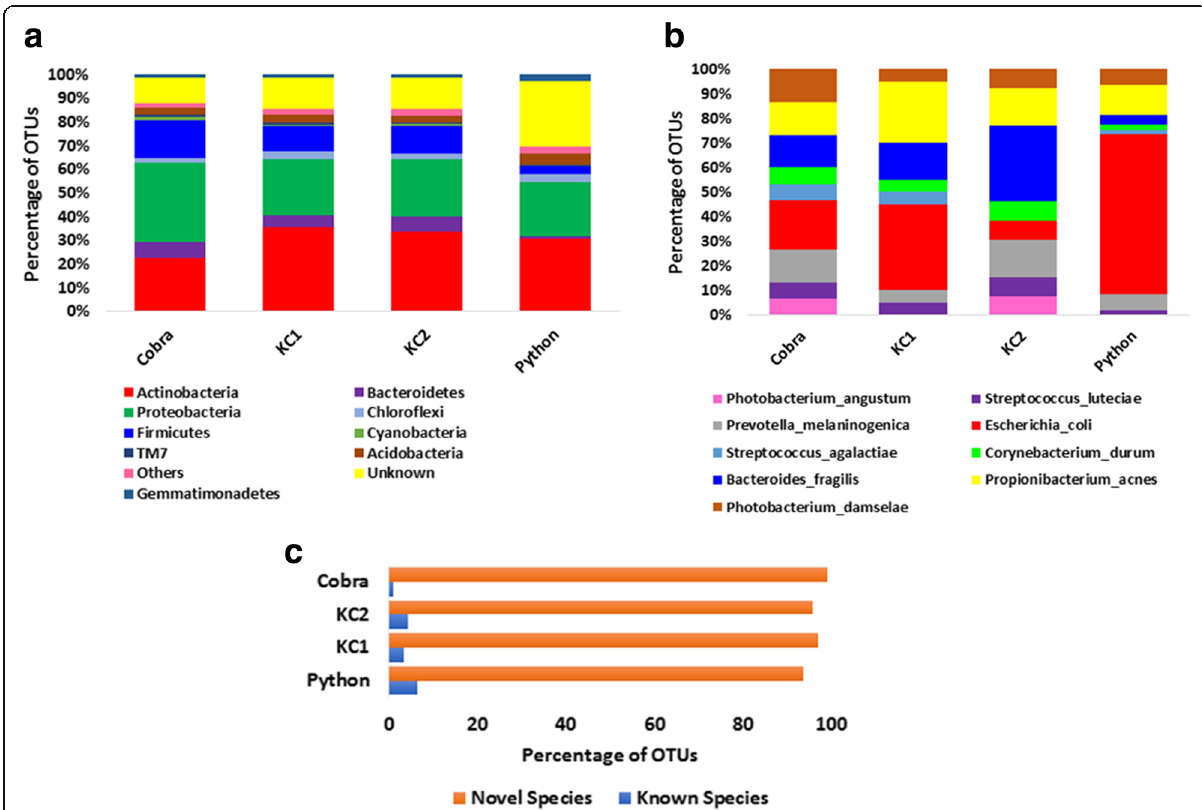
Fig. 2 Taxonomy relative abundance plot of Cobra, King Cobra and Python oral samples. a The bar plot represents the relative OTU abundance of Cobra, King Cobra 1 (KC1), King Cobra 2 (KC2) and Python samples at the phylum level. In total, about 88% of OTUs were assigned to a known phylum while 12% of OTUs were designated as unknown. Actinobacteria and Proteobacteria were predominantly present in all the samples; b The bar plot shows percentage-wise relative OTU abundance at the species level. Escherichia coli , Bacteroides fragilis and Propionibacterium acnes were the most dominant species among the samples; c The plot shows the percentage of known and novel species identified after OUT-based clustering and annotation. Forty percent of the total OTUs were classified into a known genus. Likewise, 10% of OTUs were assigned a